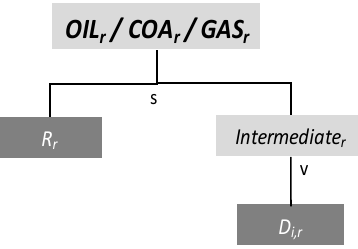
Figure A4. Nesting structure of the resource using fossil fuel sectors without process emissions in production in the CGE model.